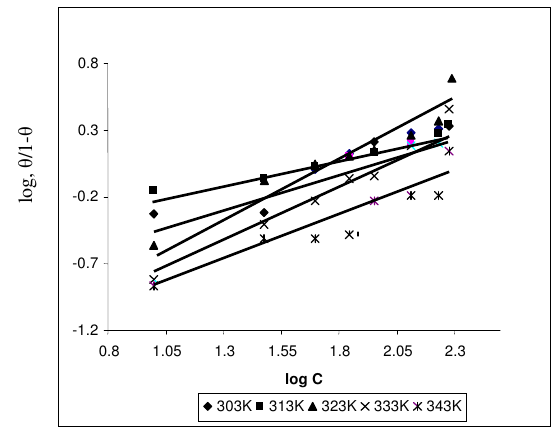
Figure 1. Langmuir adsorption